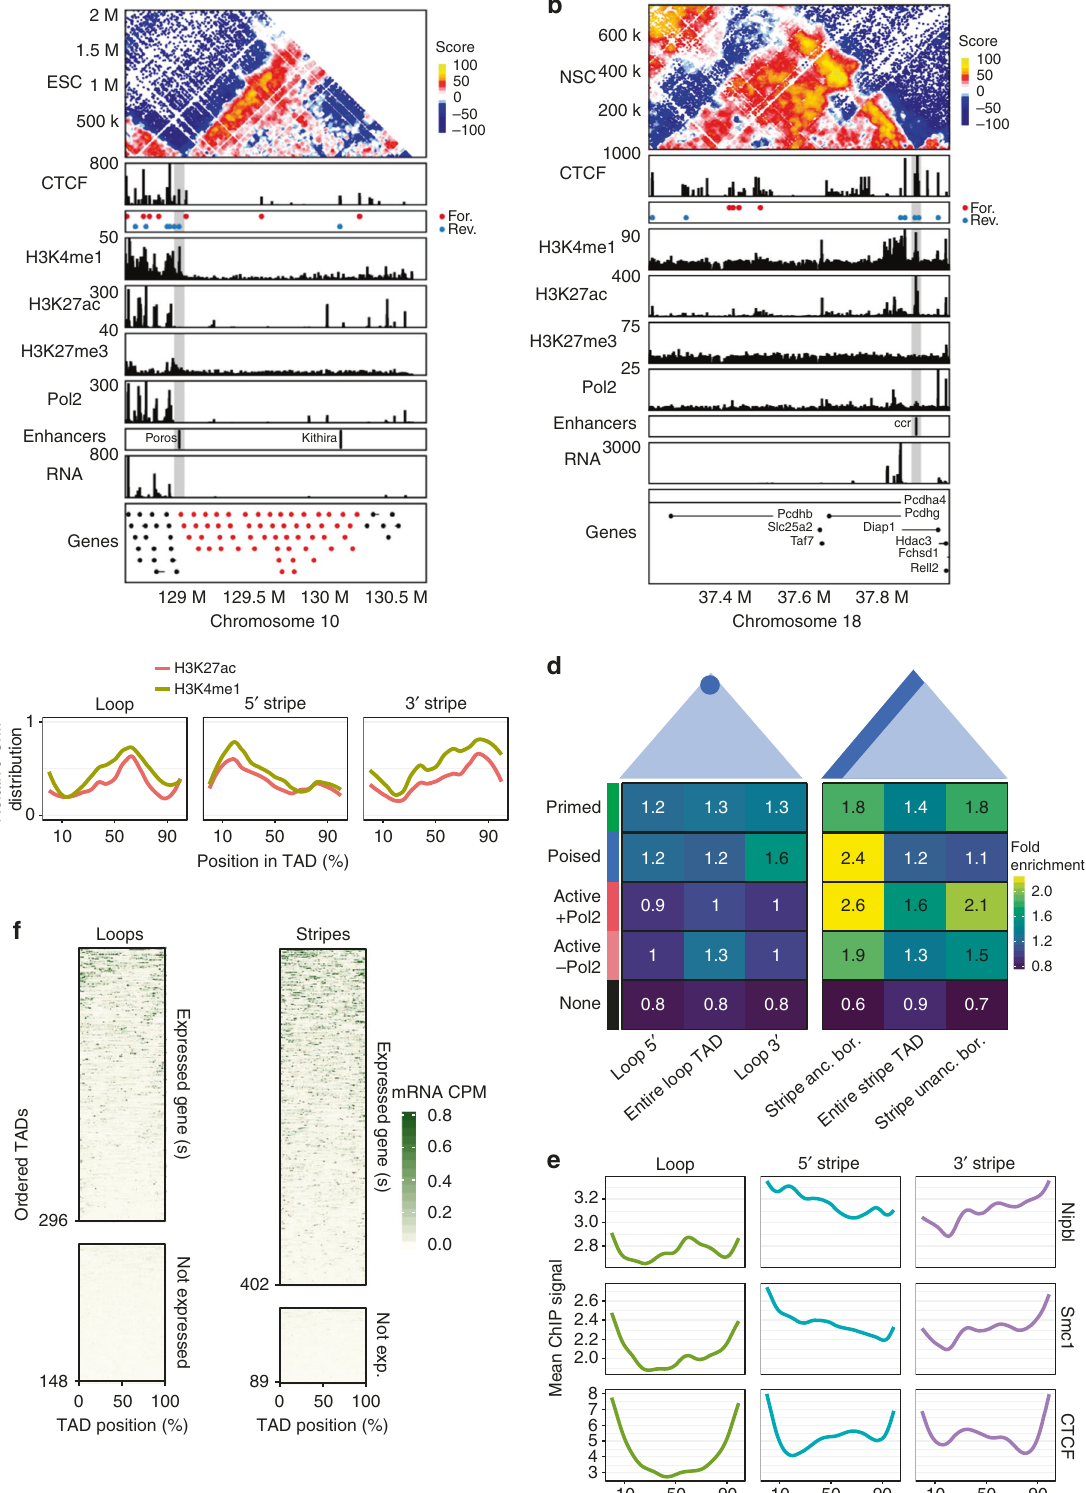
enriched at the TAD borders. In stripe domains, NIPBL signal was maximal at the anchored border and progressively decreased throughout the TAD towards the unanchored border (Fig. 3e, top row), as was observed for the enhancer marks and TFs. Inter- estingly, the relative enrichment of Smc1 followed the